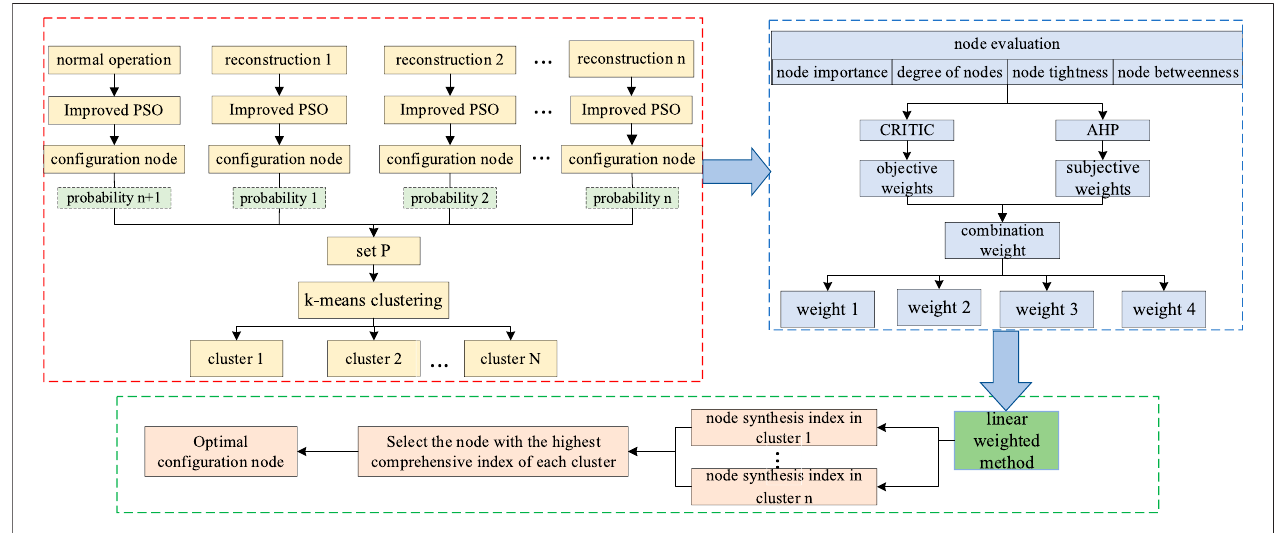
FIGURE 1 | Optimization process model diagram.